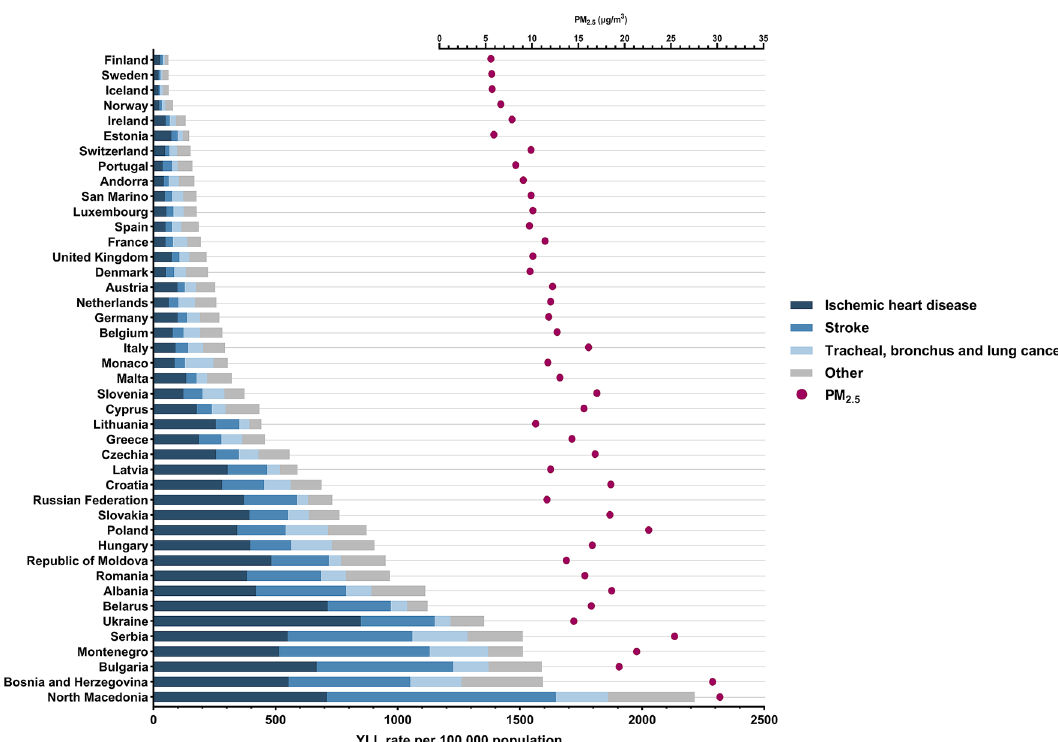
Figure 4. Age-standardised YLL rate per 100,000 and average annual population-weighted aPM 2.5 in